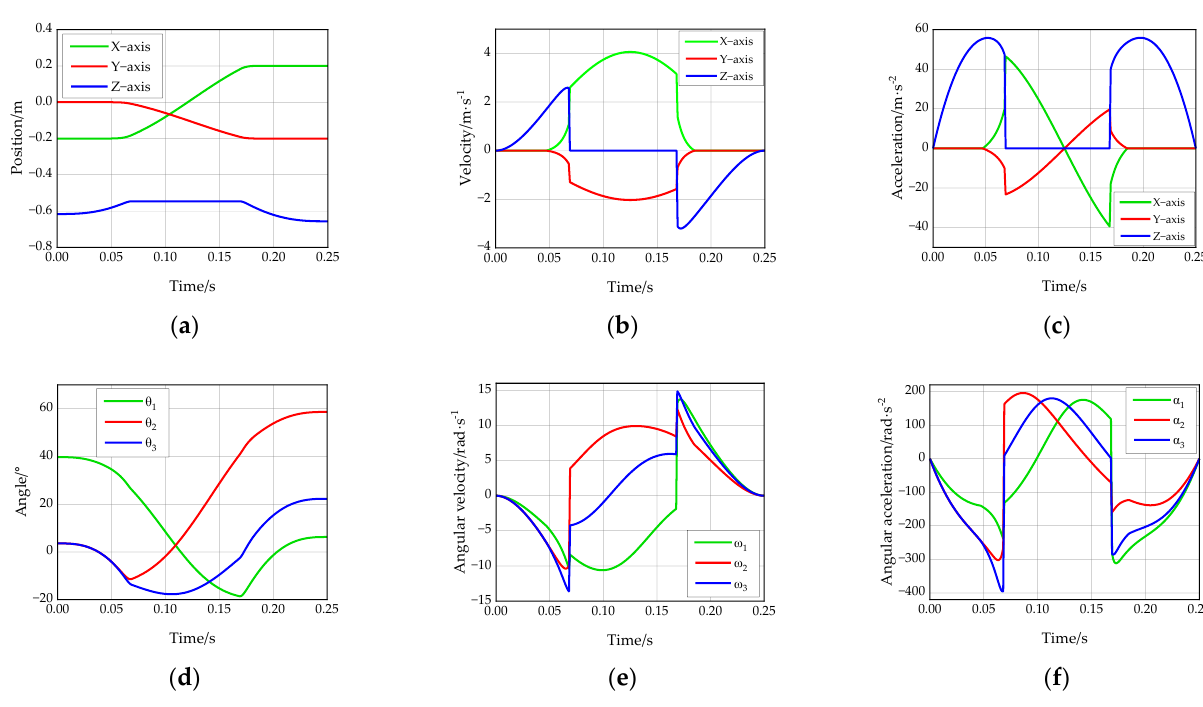
Figure 3. Trajectory of the Delta robot.